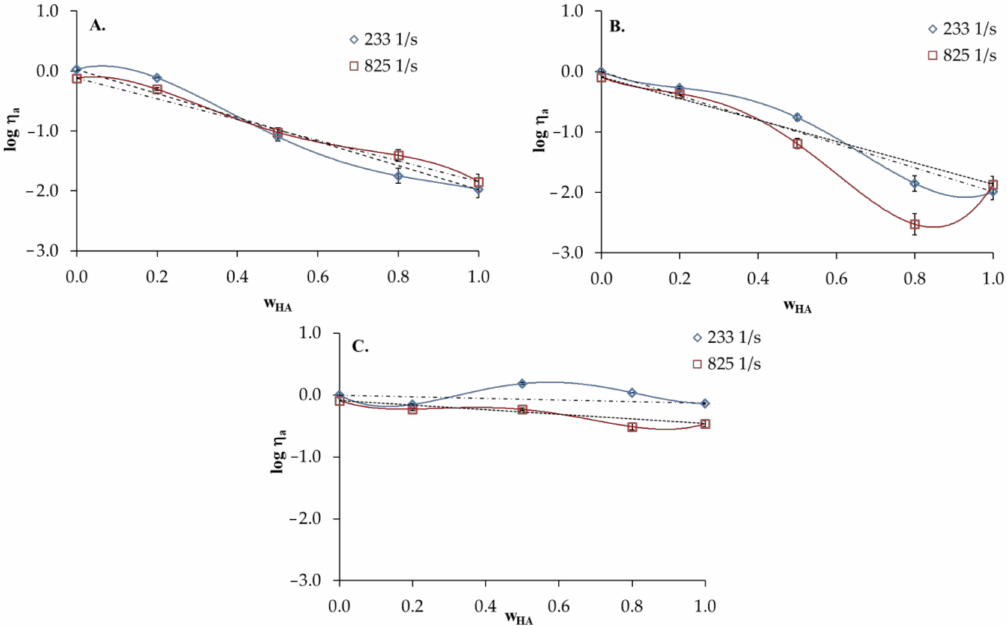
Figure 5. Logarithm of apparent shear viscosity of HA and PVA and their blends versus hyaluronic acid weight fraction ( w HA ) in the blends: ( A ) distilled water; ( B ) 0.1 mol dm − 3 NaCl; ( C ) 0.1 mol dm − 3 HCl, T = 25 ◦ C, dotted line—values calculated according to the additivity